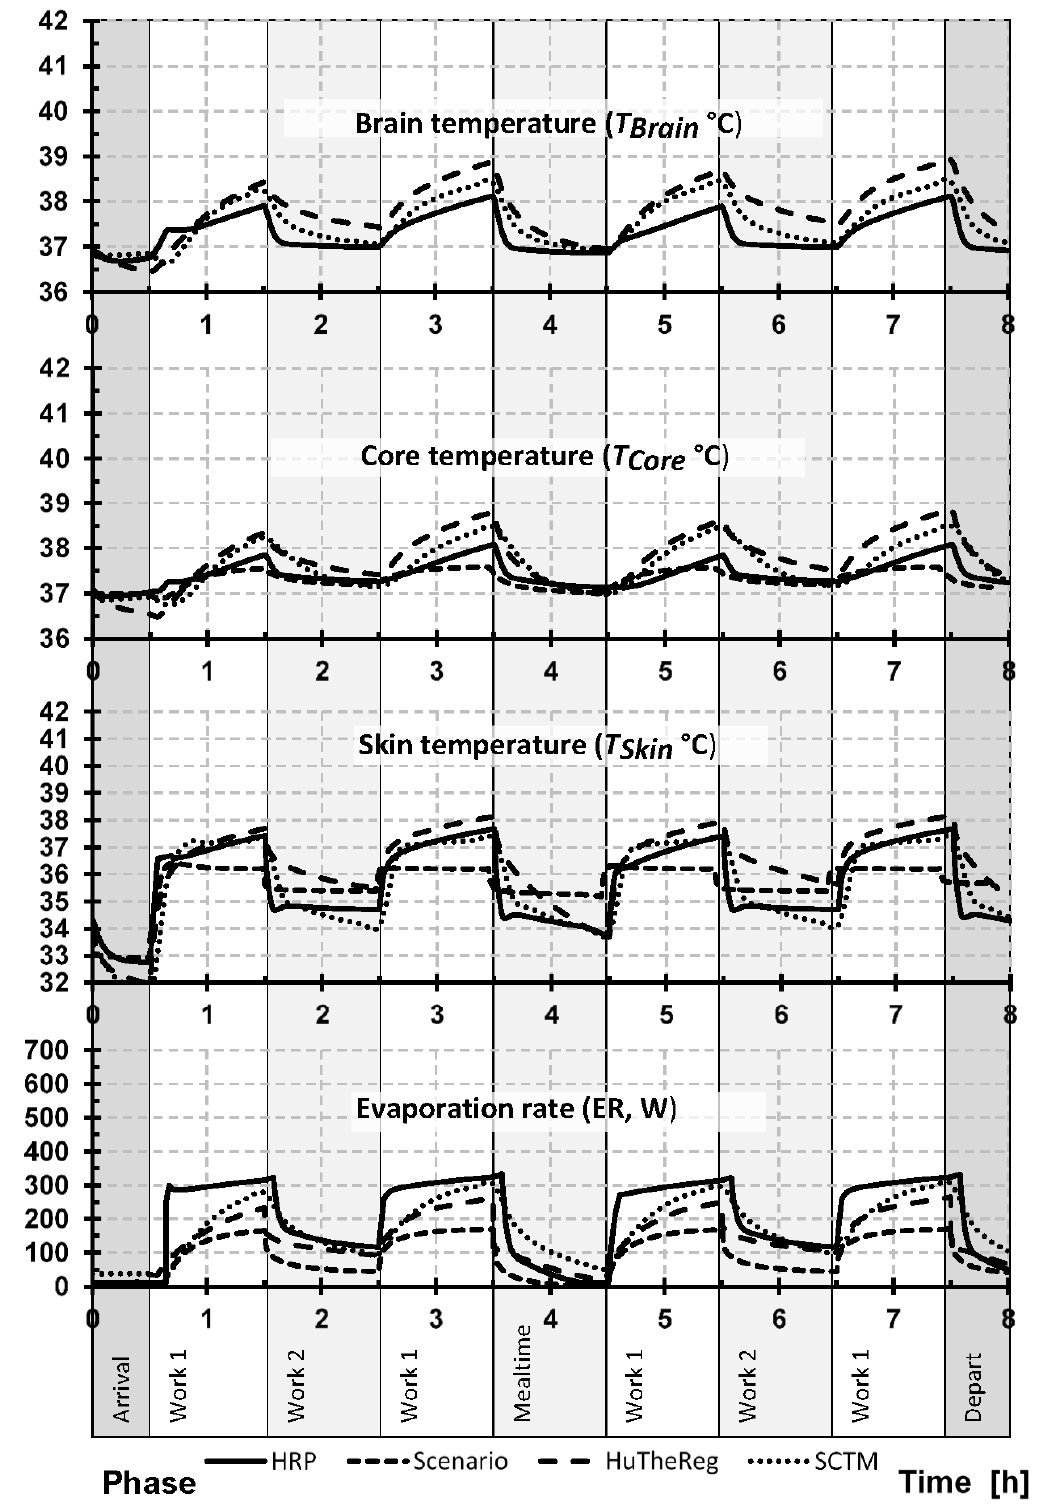
Figure 1. Predicted response pattern of brain, skin, and core body temperatures and evaporation rate during the entire work shift for moderately hot conditions (G_12). Note: HRP, health-risk prediction (HRP) model; HuTheReg, human thermal regulation model (HuTheReg); SCTM, six-cylinder thermoregulatory model.